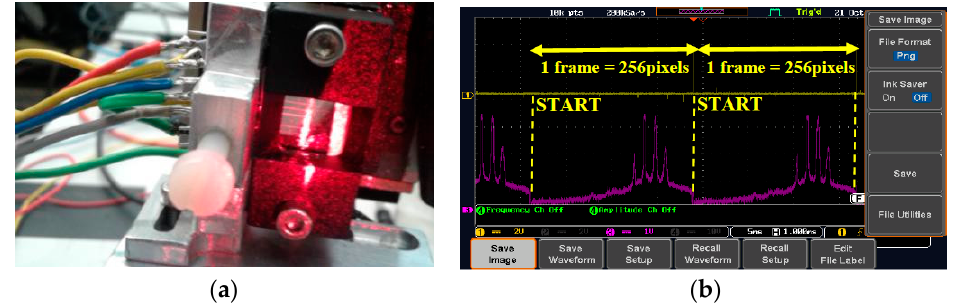
Figure 3. ( a ) Detail of the optical grating sensor with several coupled beams and the holder for the array of photodetectors on the left; ( b ) pixel array signal from 4 coupled